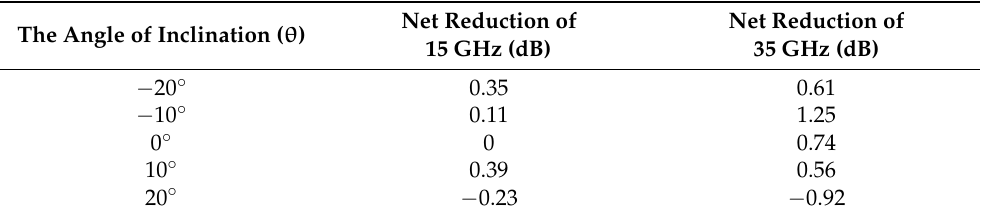
Figure 6. Machining TCR models.